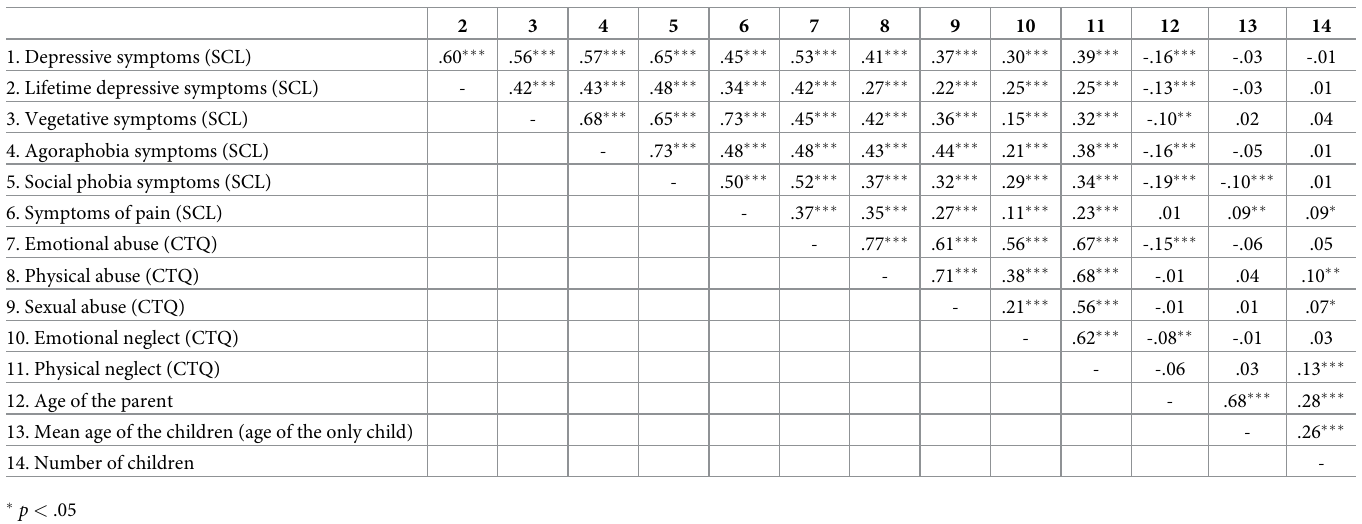
Table 2. Correlations between study variables (Study